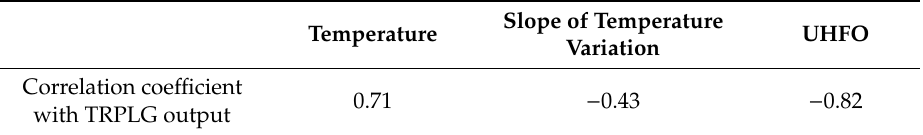
Table 1. Correlation coe ffi cient between TRPLG output and parameters. Slope of Temperature Temperature Variation